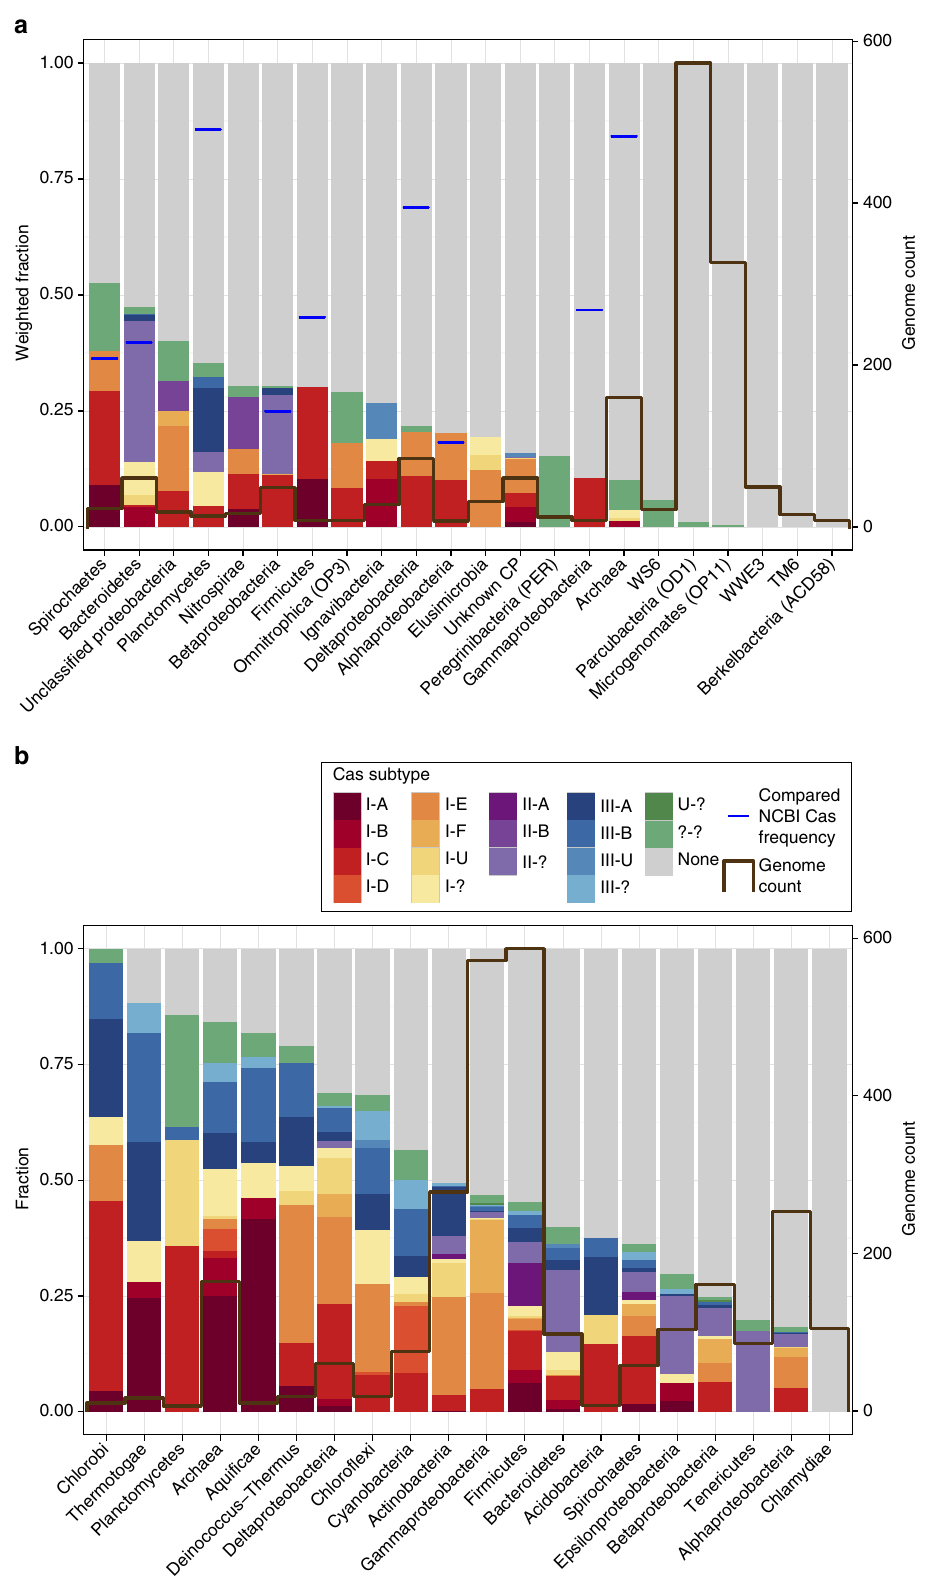
Figure 1 | The frequency of cas operons in different lineages. ( a ) Rifle groundwater metagenomic data sets and ( b ) NCBI complete bacterial and archaeal genomes. Only lineages with more than ten genomes are presented. Column heights are normalized for genome completeness, column colours represent CRISPR-Cas type, and the bold brown line represents the number of genomes. Blue vertical lines in a represent the fraction of genomes with CRISPR-Cas among NCBI complete genomes for applicable lineages. Two superphyla and four phyla in the groundwater samples, including the two most abundant ones, superphyla Parcubacteria (OD1), and Microgenomates (OP11), have an extremely low incidence of cas operons. NATURE COMMUNICATIONS|7:10613|DOI: